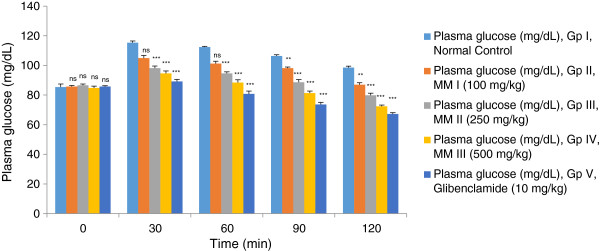
Effect of Melastoma malabathricum Linn. (MM) on fasting plasma glucose on oral glucose tolerance test at different concentrations on STZ induced diabetic rats, compared to standard drug Glibenclamide; values are mean ± SEM; n = 6; *P < 0.05; **P < 0.01; ***P < 0.001; P > 0.05 is considered as non-significant (ns).